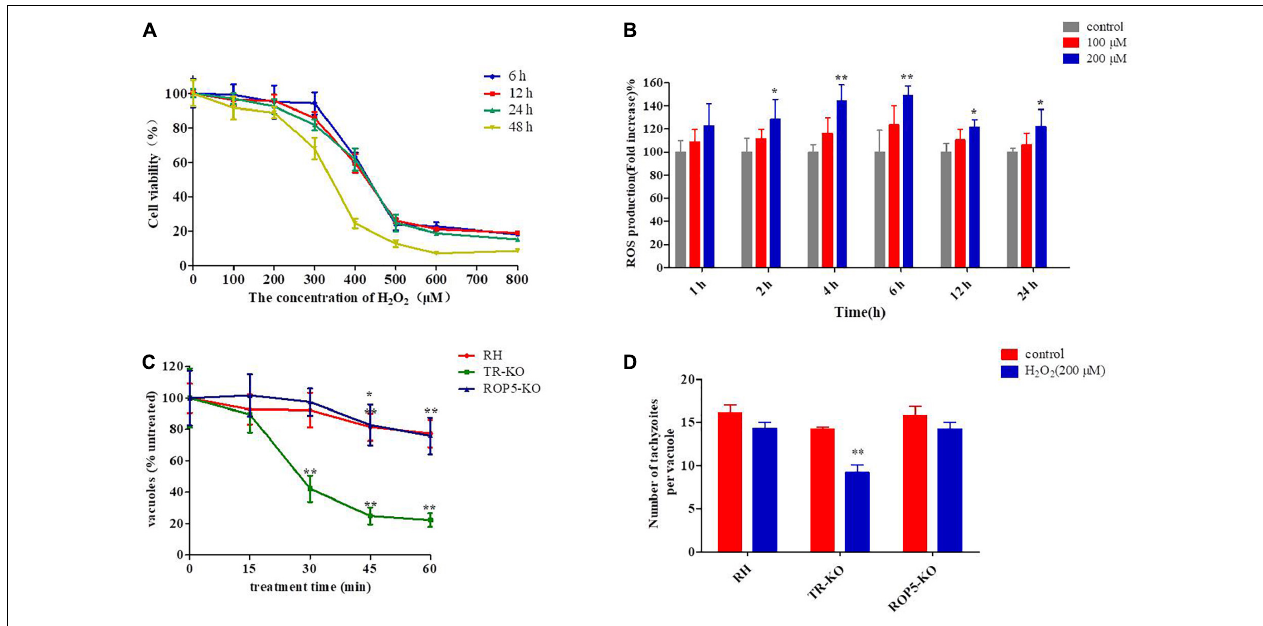
FIGURE 1 | Effect of H 2 O 2 on Vero cells and different strains of Toxoplasma gondii . (A) Vero cells were treated with various concentrations of H 2 O 2 (0, 100, 200, 300, 400, 500, 600, and 800 µ M) for 6, 12, 24, and 48 h and then measured using Cell Counting Kit-8. The viability percentage was determined from the absorbance ratio of the treated cells to the control cells ( n = 4). (B) Vero cells were treated with various concentrations of H 2 O 2 (0,100, and 200 µ M) for 1, 2, 4, 6, 12, and 24 h. Intracellular ROS were determined using the Reactive Oxygen Species Detection Assay Kit, and ROS levels are expressed as the fold-change in fluorescence intensity in the test group compared with the untreated group. (C) Viability was measured for extracellular parasites (RH, TR-KO, ROP5-KO) treated with 200 µ M H 2 O 2 for 15, 30, 45, and 60 min; next, treated parasites were allowed to infect Vero cells. Vacuoles containing four or more parasites were measured and normalized to the number of untreated parasites incubated at the same time outside of the cell. (D) Parasites were treated with or without H 2 O 2 (200 µ M) after 12 h of infection. Parasite replication was quantified for the three strains by counting the number of parasites per vacuole and presented as the mean of parasites per vacuole. The replication assay for the treated group was compared to that for the untreated group. The results are presented as the mean ± standard deviation of three (B,D) , four (A) , or five (C) independent experiments. ** P < 0.01, * P < 0.05 significant changes versus control/RH